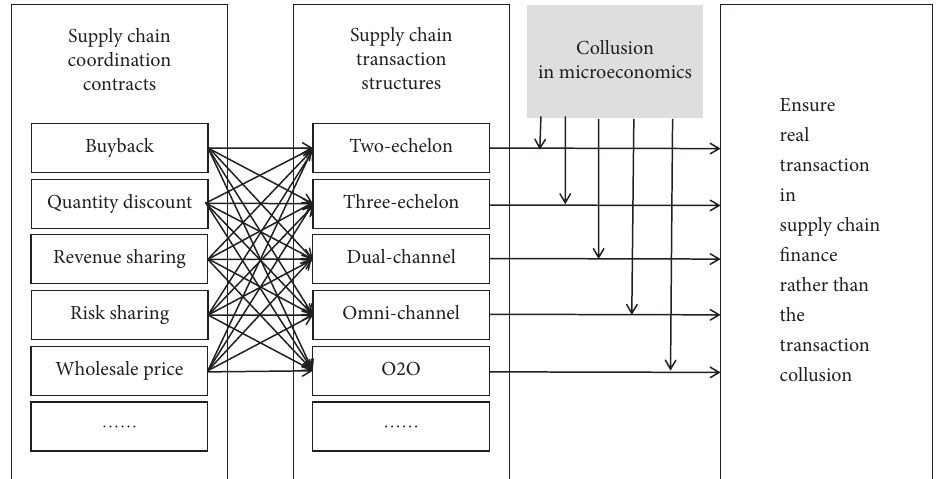
Figure 7: Research directions.